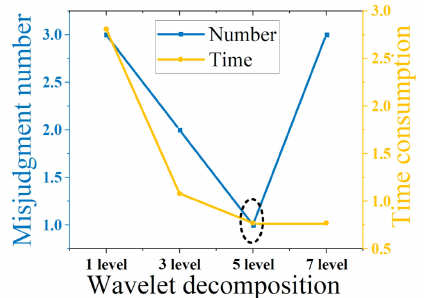
Figure 10. Comparison of the results for different wavelet